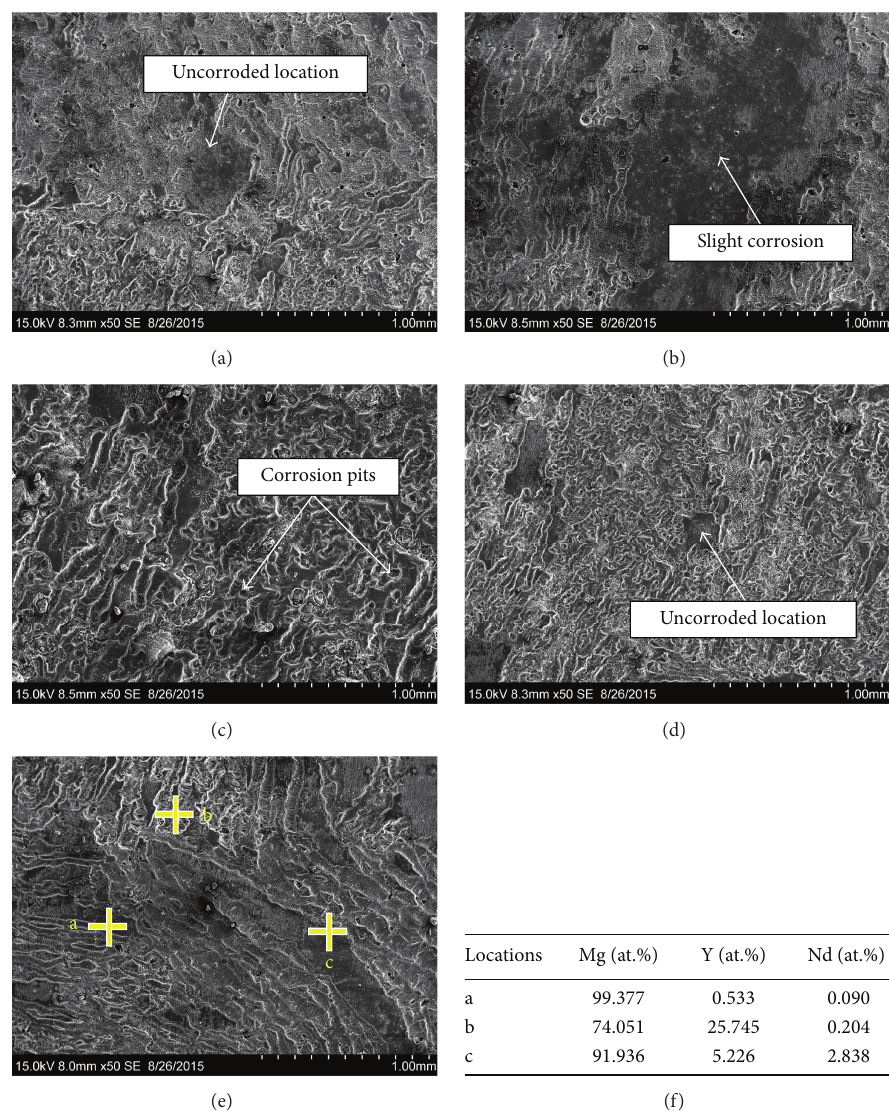
Figure 6: The surface morphologies without corrosion products of different samples: (a) as-cast, (b) T4, (c) T6-6h, (d) T6-14h, (e) T6-24h, and (f) EDS